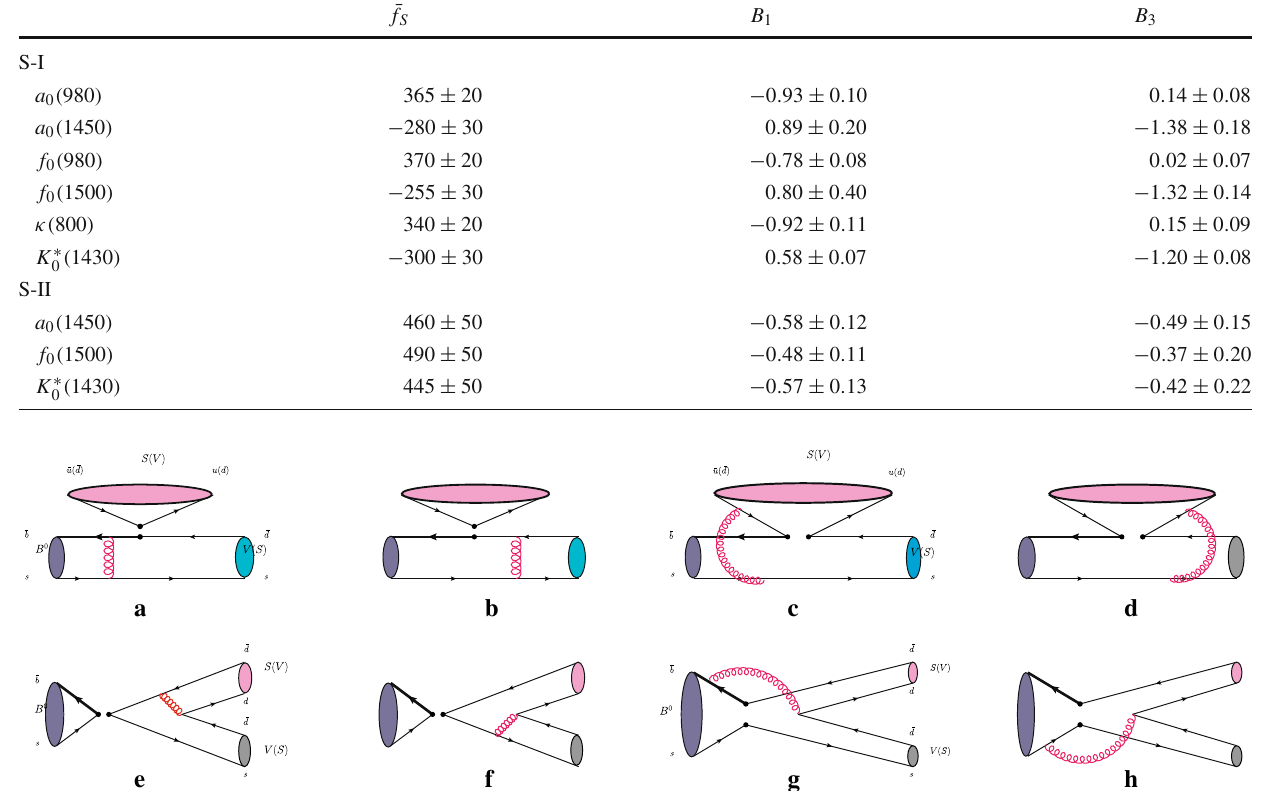
Table 1 Decay constants ¯ f S (in unit of MeV) and Gegenbauer moments at scale μ = 1GeV in S-I and S-II [4–6]